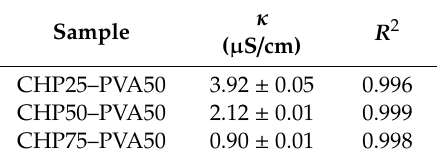
Table 6. Conductivity of the composite films, calculated as a slope of the linear function.